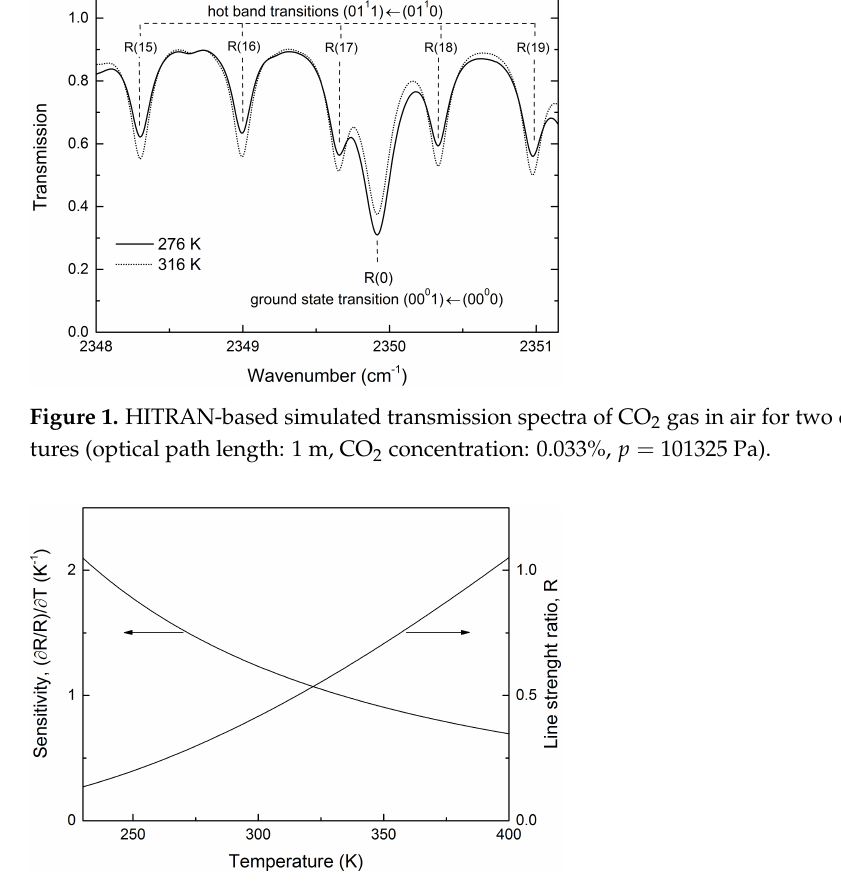
Figure 2. Simulated temperature-dependent line strength ratio, R , and sensitivity, ( dR / R ) / dT , of the R(0) ground state (2349.92 cm − 1 ) and R(17) hot band (2349.65 cm − 1 ) transition.